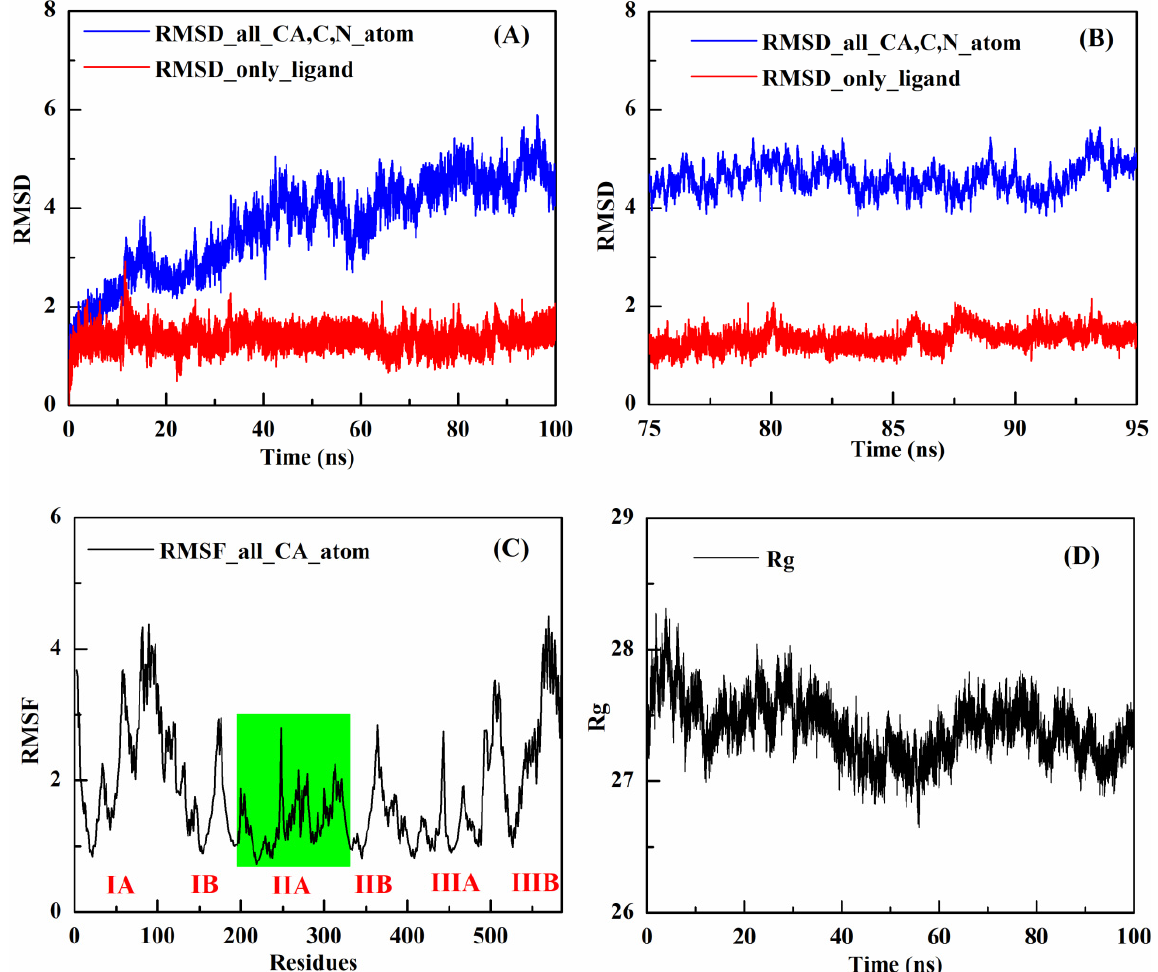
Figure 3. ( A ) The change curves of RMSDs of the backbone atoms of HSA (blue) and the heavy atoms of GDC-0941 (red) relative to the initial structure in the HSA–GDC-0941 complex system along the simulation time. ( B ) Partial enlarged view of the RMSD simulation time from 75 to 95 ns. ( C ) RMSF values of the HSA–GDC-0941 complex system plotted against residue numbers. ( D ) Time dependence of the Rg for the backbone atoms of HSA during the simulation in the presence of GDC-0941.